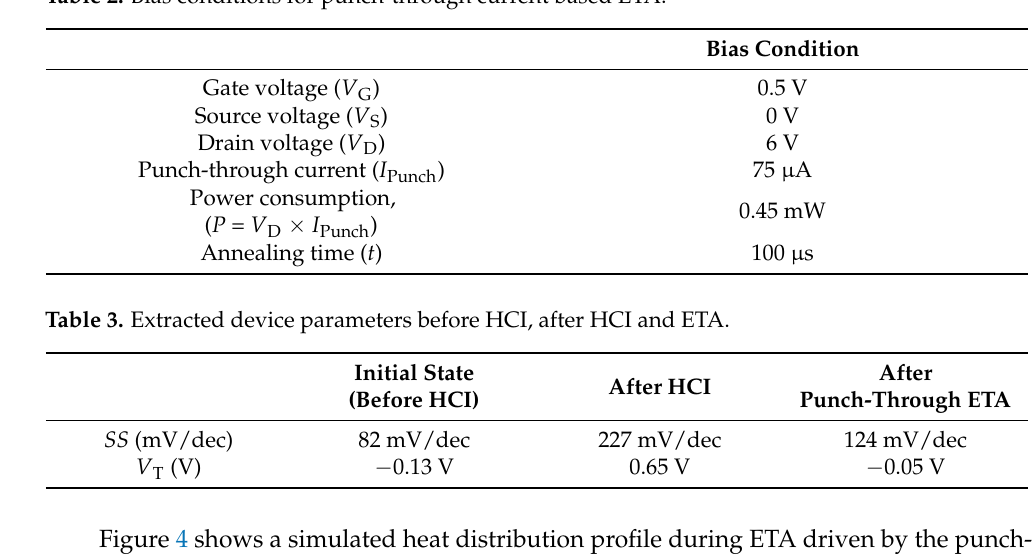
Figure 5. Extracted T Channel of devices with various ( a ) gate lengths and ( b ) gate heights under an identical power consumption of 0.45 mW. Dashed lines indicate linear fits of the experimental data. As the physical gate length and the height of the device were reduced, the tempera ‐ ture during ETA increased. Typically, the gate electrode acts as the heat sink during ETA. As the volume of the gate decreased, the temperature during ETA increased due to the reduced heat sink. The consistent high temperature generated during ETA under identical applied power consumption represented better power efficiency for gate dielectric curing. In this context, considering the extracted sensitivity of temperatures with respect to the gate length and the height, it would be more efficient to apply gate length scaling rather than the gate height. In addition, the gate module includes not only the gate electrode itself but also dielectric materials such as gate dielectric, gate spacer, and gate hard mask. 50